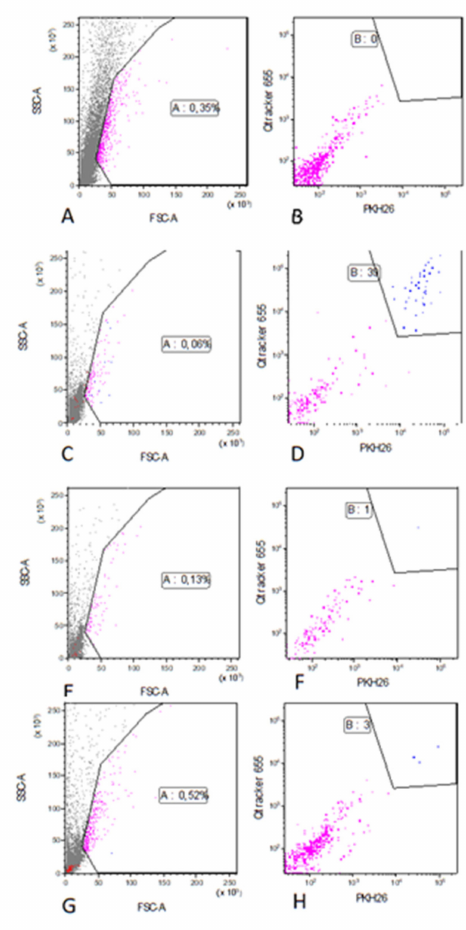
Figure A4. Example of flow cytometry results of arterial tubing samples. ( A ) T = 0 sample moment, FSC-A, SSC-A cytogram, purple dots represent cells that fall within the MSC gating; 0.35% of all counts. ( B ) PKH26 and Qtracker655 cytogram of T = 0 sample, purple dots represent particles that fall in the auto fluorescence range, no dots visible in the MSC range gate. ( C ) T = 60 sample moment, FSC-A, SSC-A cytogram, purple dots represent cells that fall within the MSC gating; 0.06% of all the cells. ( D ) PKH26 and Qtracker655 cytogram of T = 60 sample moment, purple dots represent particles that fall in the auto fluorescence range, blue dots represent cells that fall within the MSC range gate; 6.5% of the counted particles. ( E ) T = 240 sample moment, FSC-A, SSC-A cytogram, purple dots represent cells that fall within the MSC gating; 0.13% of all cells. ( F ) PKH26 and Qtracker655 cytogram of T = 240 sample moment, purple dots represent particles that fall in the auto fluorescence range, blue dot represents the cell that fall within the MSC range gate; 0.08% of the counted particles. ( G ) T = 420 sample moment, FSC-A, SSC-A cytogram, purple dots represent cells that fall within MSC gating; 0.52% of all counted cells. ( H ) PKH26 and Qtracker655 cytogram of T = 420 sample moment, purple dots represent particles that fall in the auto fluorescence range, the blue dots represent cells with a double fluorescent label that fall within the MSC gating; 0.06% of the counted